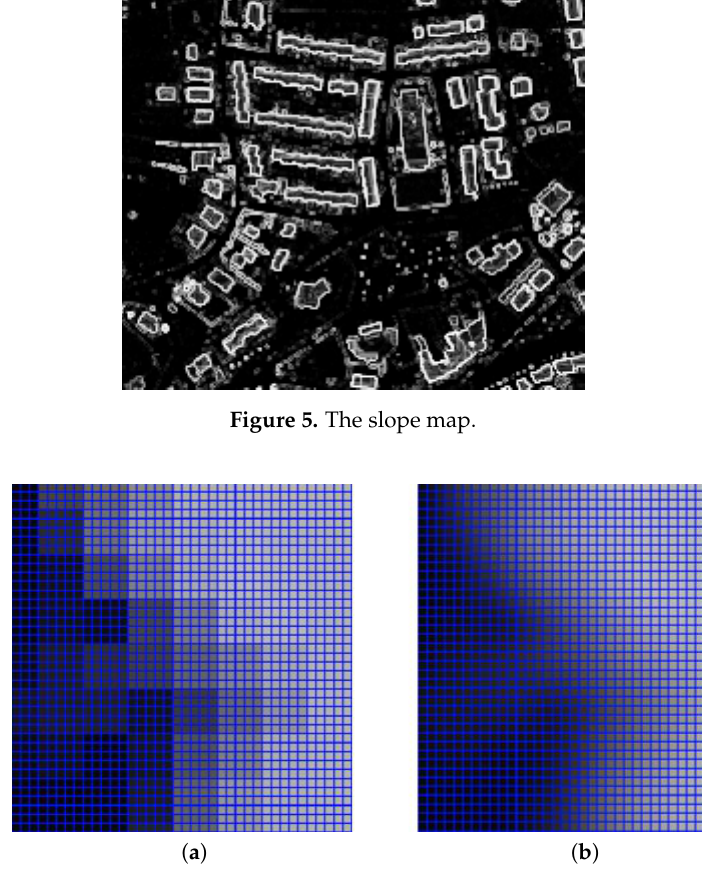
Figure 6. Pixels of the WordView-2 image before ( a ) and after the smoothing ( b ). Courtesy of the authors of